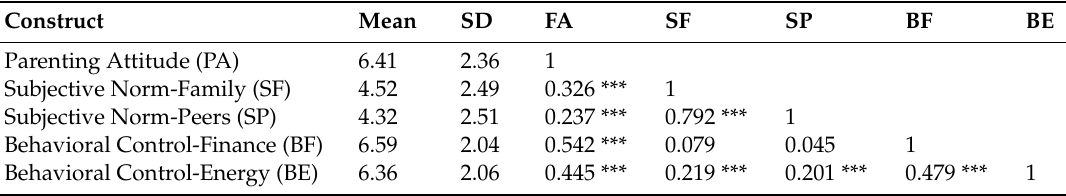
Table 4. The mean of di ff erent variables and their correlations.